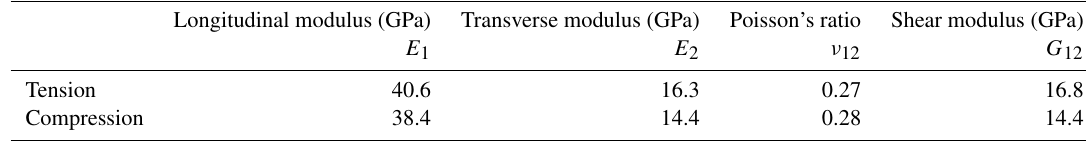
Table 1. Empirical material properties utilized in progressive damage